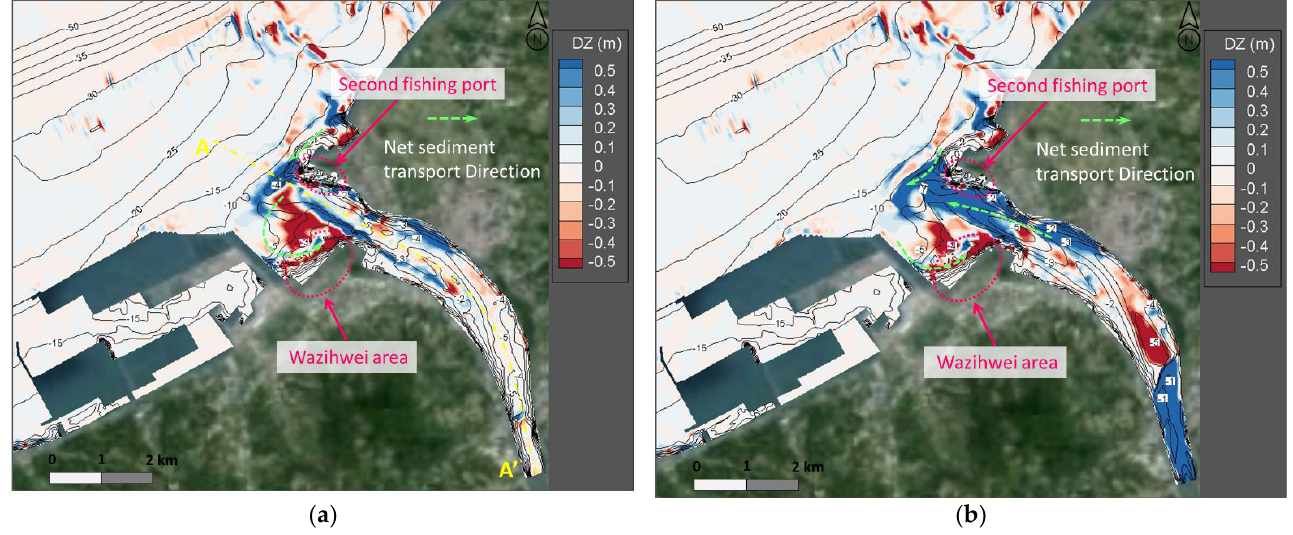
Figure 11. Changes in topographical erosion and deposition in the Tamsui River estuary after the end of the first year’s monsoon and typhoon seasons (DZ = bed change, the contour line is bed elevation. The unit is meters for both). ( a ) At the end of monsoon season of the first year. ( b ) At the end of the first-year hydrographs.